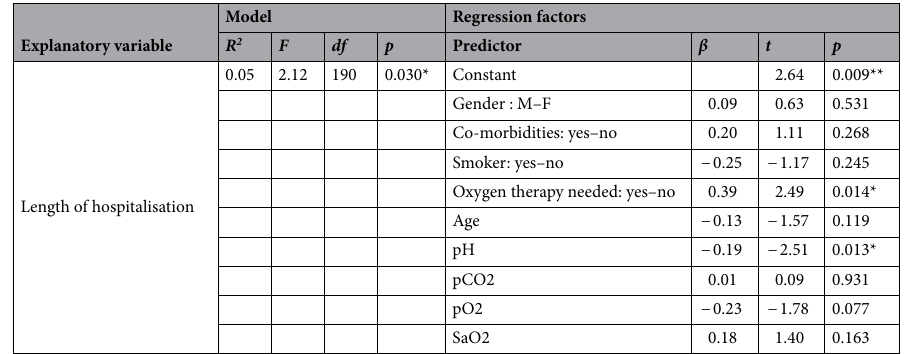
Table 3. Predictive factors for extending the duration of hospitalisation in patients diagnosed with COVID- 19. R 2 —coefficient for model fit; F —test statistic; df —degrees of freedom; β —standardised coefficient beta; t —test statistic; p —statistical significance; * p < 0.05; ** p < 0.01; *** p < 0.001.